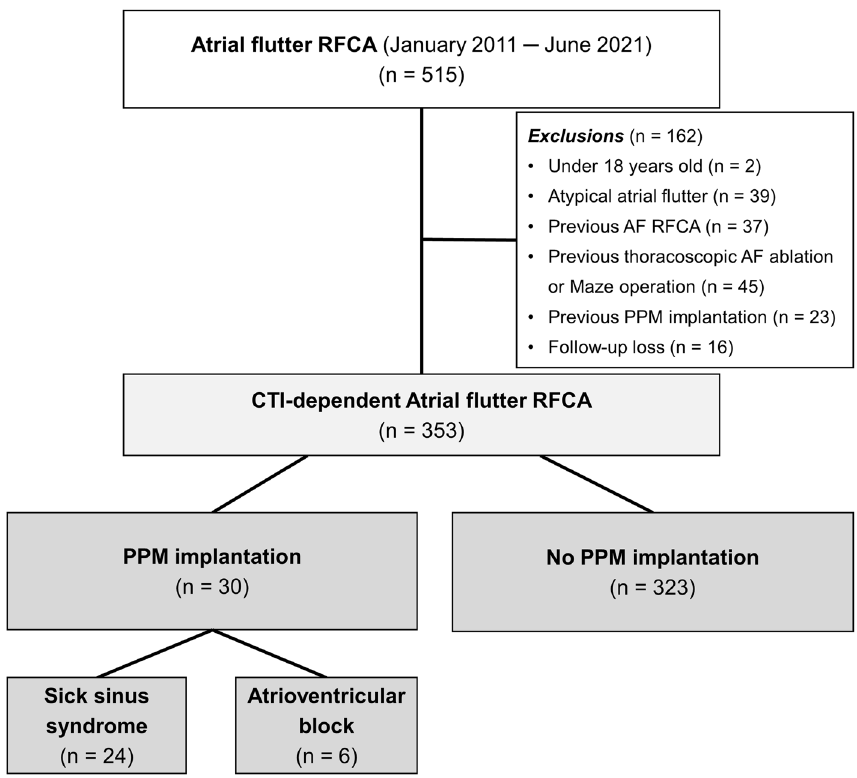
Figure 1. Study flow. AF atrial fibrillation, CTI cavotricuspid isthmus, PPM permanent pacemaker, RFCA radiofrequency catheter